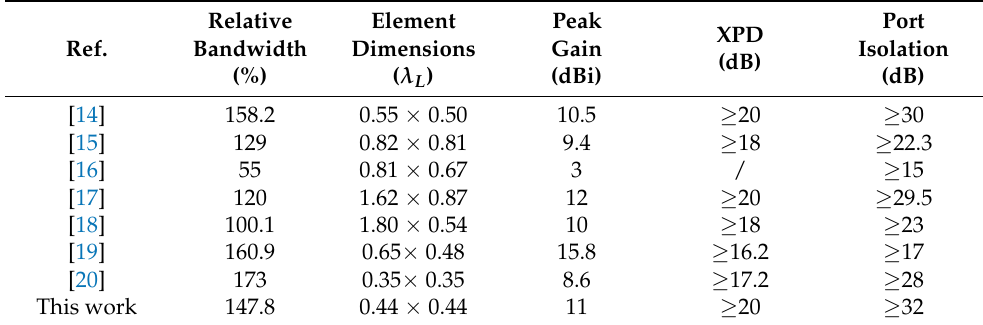
Table 2. The performance comparisons of the dual-polarized TSAs. Relative Ref. Bandwidth (%)